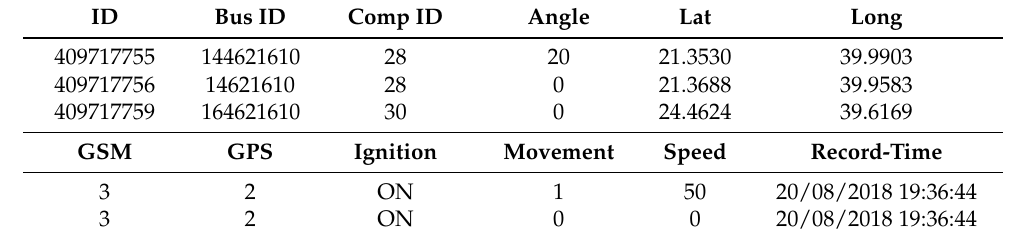
Table 1. Sample data format.